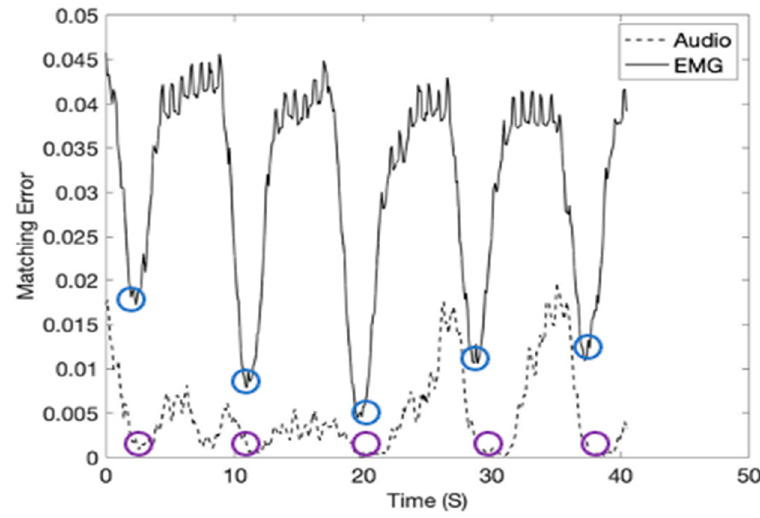
Figure 11. The breathing cycles (i.e., inspiration moments) monitored using the template signature matrices. The sensor signals were obtained from the diaphragm location (1000 mL tidal volume).